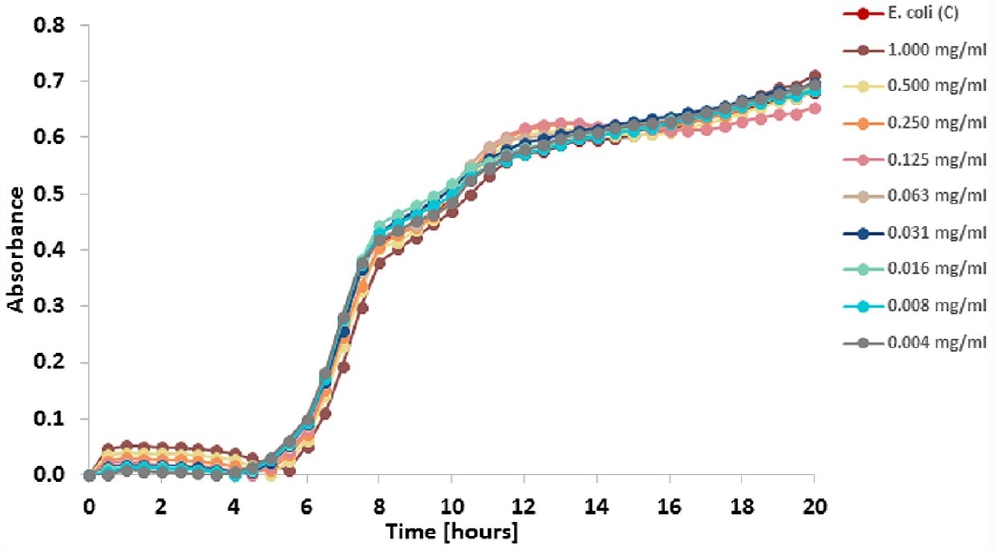
Figure 5. Growth curves of E. coli with Norway spruce green cone extracts. Table 10. MIC values of cone extracts (1 mg/mL in 1% DMSO) determined from growth curves. Bacterial Strain